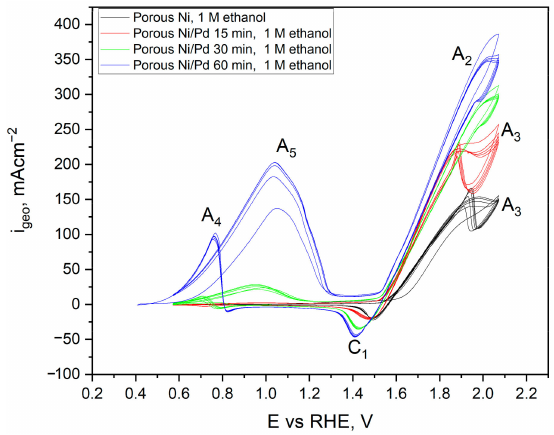
Figure 14. Cyclic voltammetry scans performed for porous Ni and Ni/Pd-decorated electrode in 1 M NaOH electrolyte with 1 M ethanol addition. Pd—decoration time: 0, 15, 30, 60 min. CVs registered with a sweep rate of 50 mV s − 1 . 10 cycles are performed in one CV